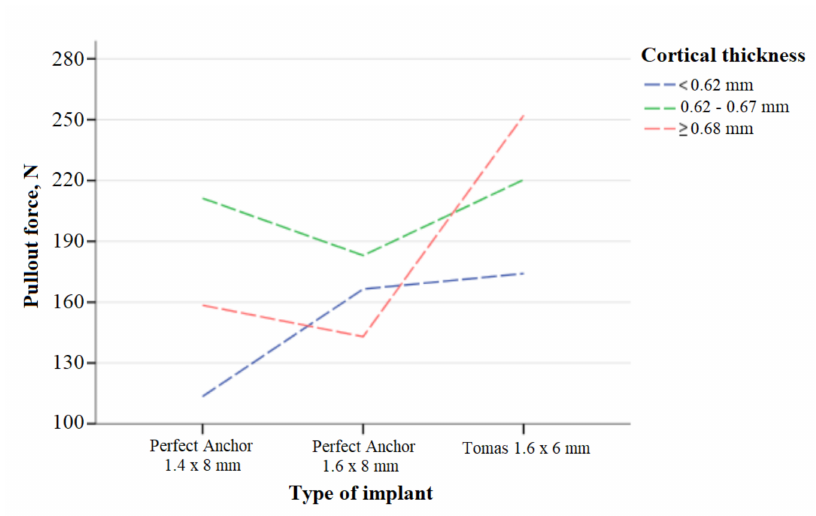
Figure 6. Statistical values of the pulling force by implant type and cortical thickness.